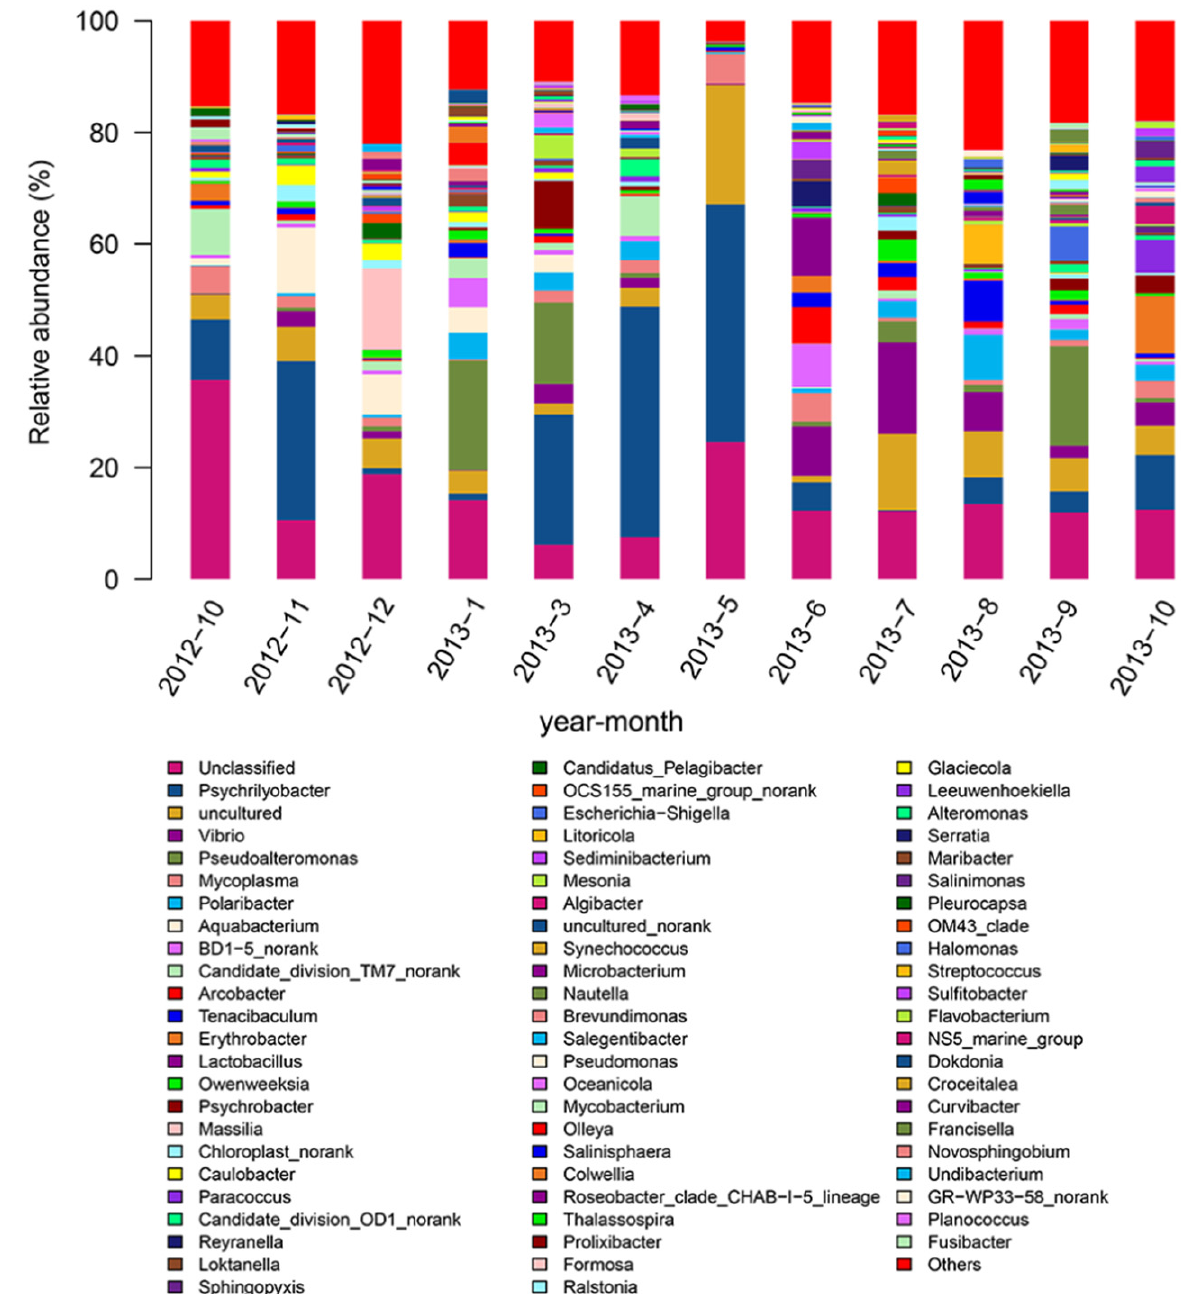
Figure 2. Genus-level abundance of bacterial community in seawater samples from artificial cement ponds for abalones in different months. The vertical coordinates indicate the relative abundance of different bacterial species. The horizontal coordinate represents the year and month. Different colors represent different bacterial species.